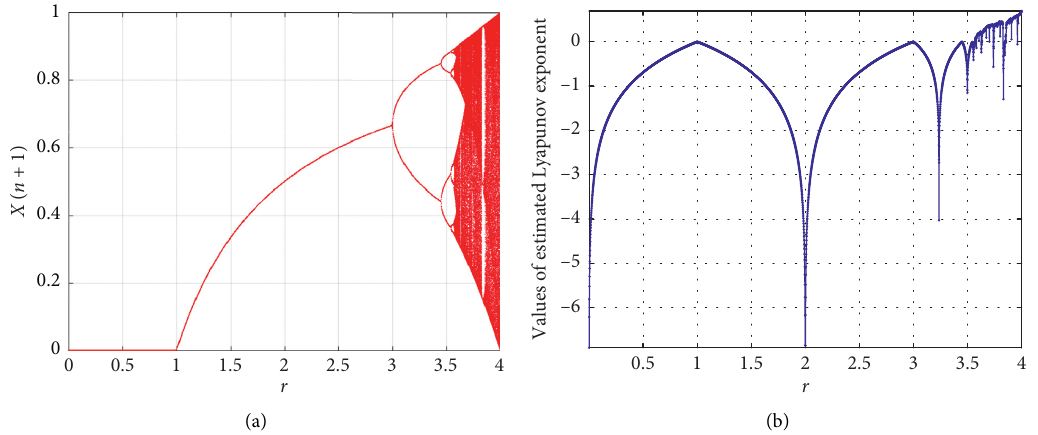
Figure 2: Logistic map: (a) Bifurcation diagram and (b) Lyapunov exponent.